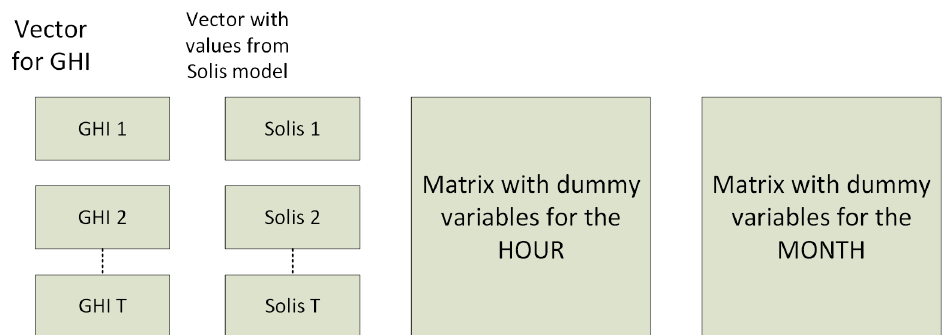
Figure 10. Composition of an input matrix in GHI training set for the RNN